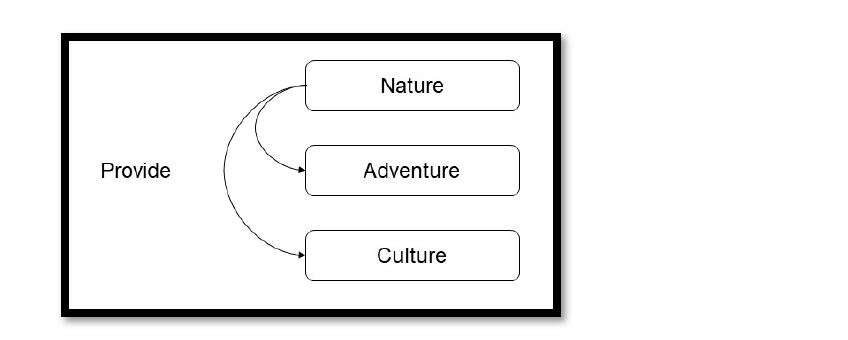
Figure 2. Images of Sabah, Malaysian Borneo projected in literature and tourist brochures.